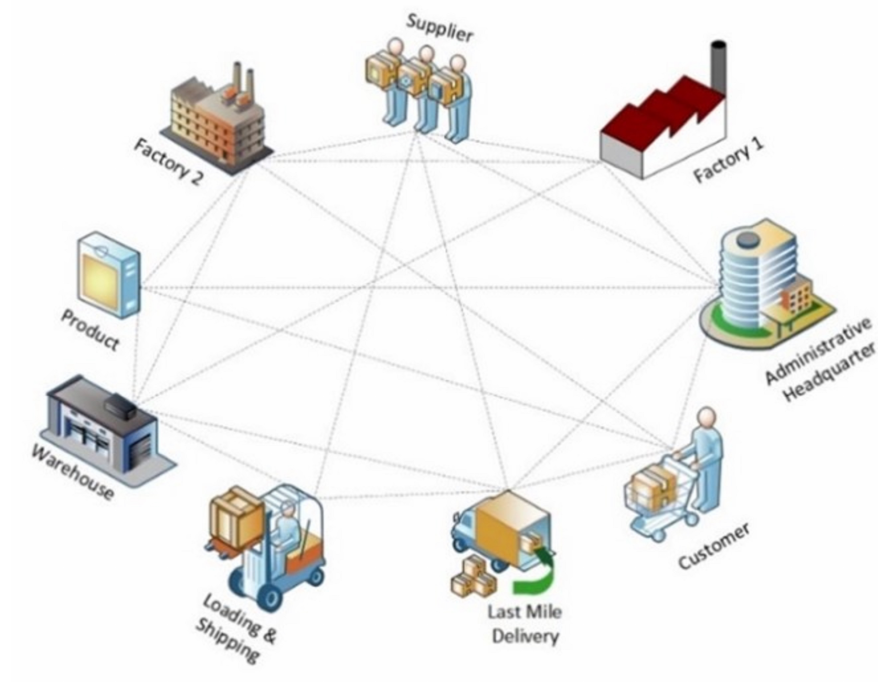
Figure 6. Horizontal